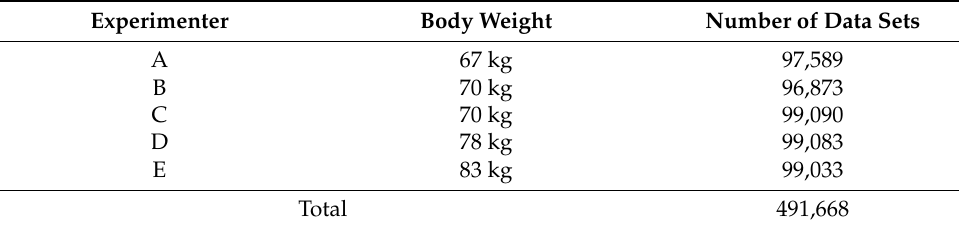
Table 2. The basic information of experimenter and the number of collected data sets.